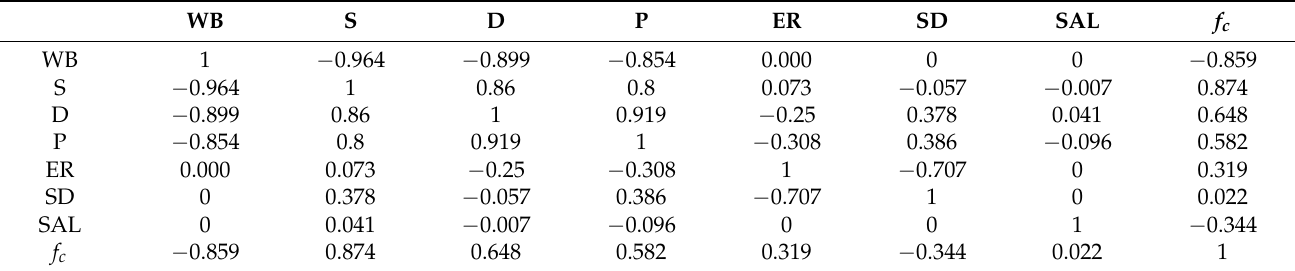
Table 6. Pearson correlation between the